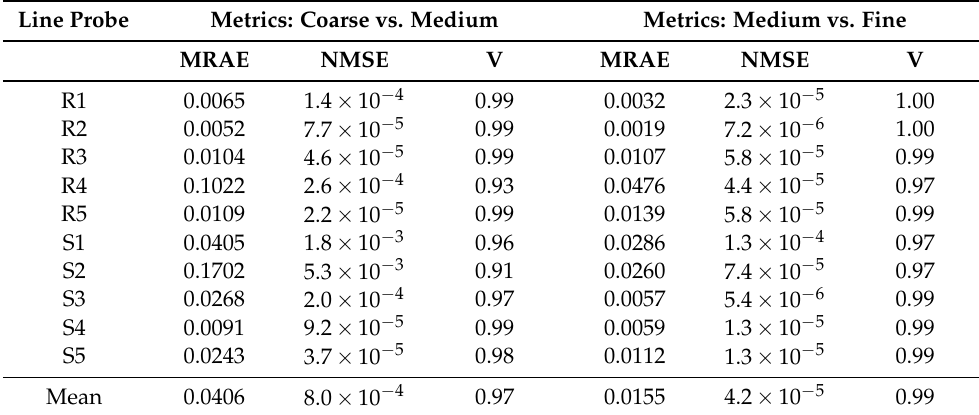
Table 4. Verification metrics for results on the applied computational grids.